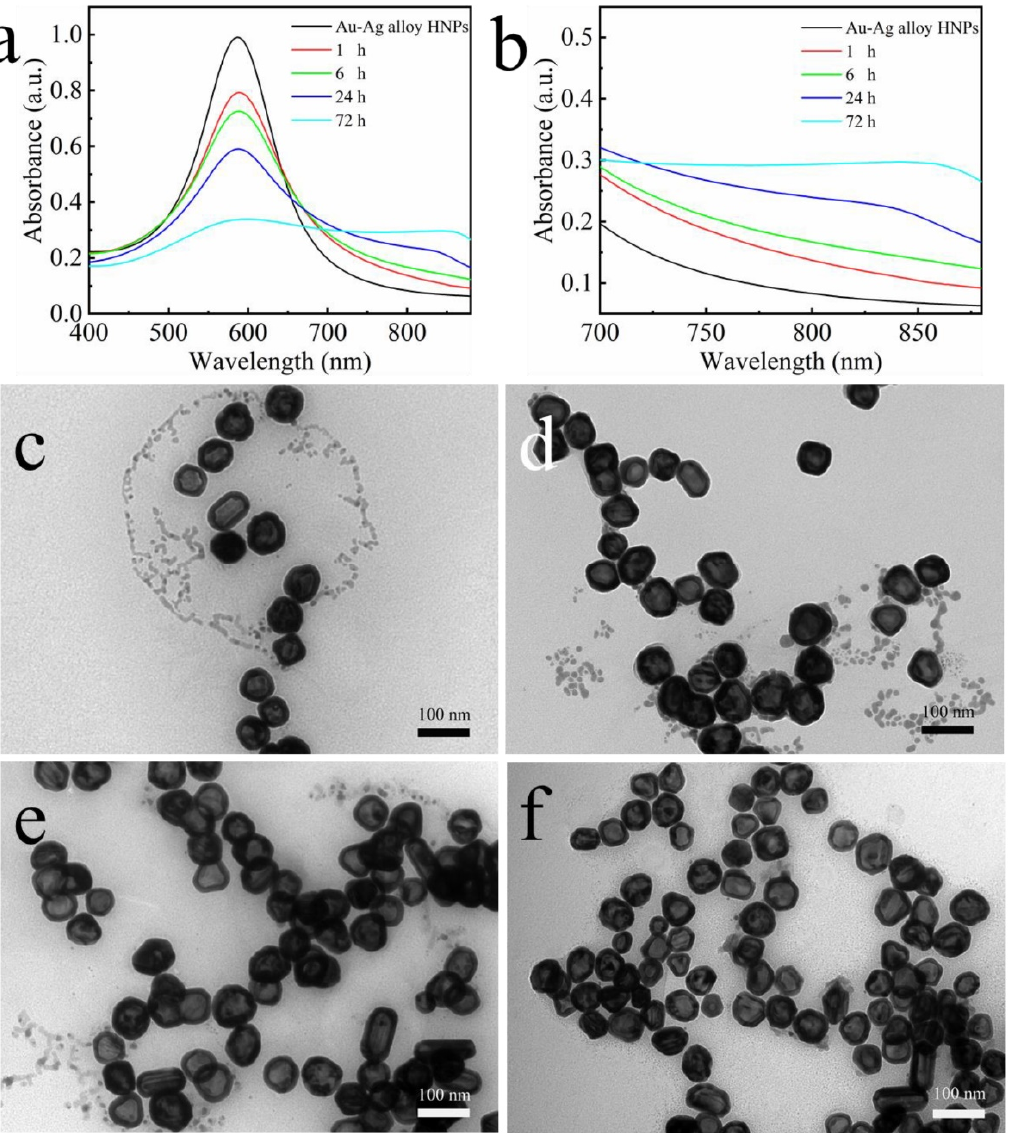
Figure 3. ( a , b ) Time-dependent UV–Vis spectra of Au–Ag alloy HNCs sol recorded at various time intervals after the addition of 1.43 mM of MEA. ( c – f ) Corresponding TEM images at ( c ) 1 h ( d ) 6 h ( e ) 72h ( f ) two weeks.